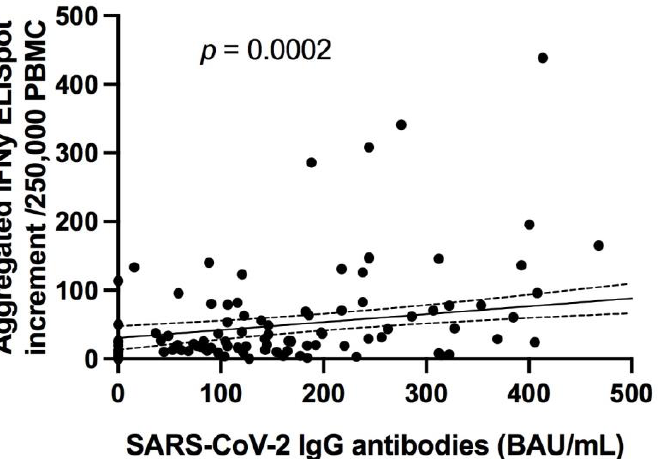
Figure 8. Correlation of SARS-CoV-2 IgG antibodies against S proteins and aggregated SARS-CoV-2 specific T cell responses in the ELISpot assays. p = 0.0002; R = 0.3, regression line (black line) with 95% confidence interval (dashed